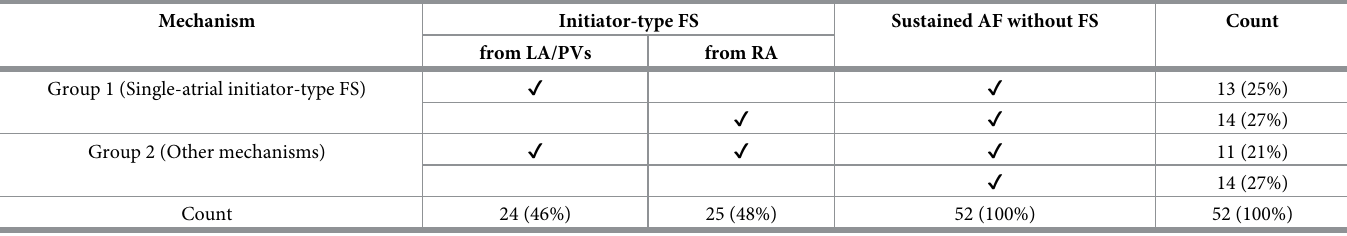
Table 3. Groupings and counts of patient-level mechanisms (by row), as well as the assignment of the patient group for survival analysis in Fig 8, based on whether a patient contains initiator-type FS coming from a single atrium. This table omits the results of patients with driver-type FS for clarity.